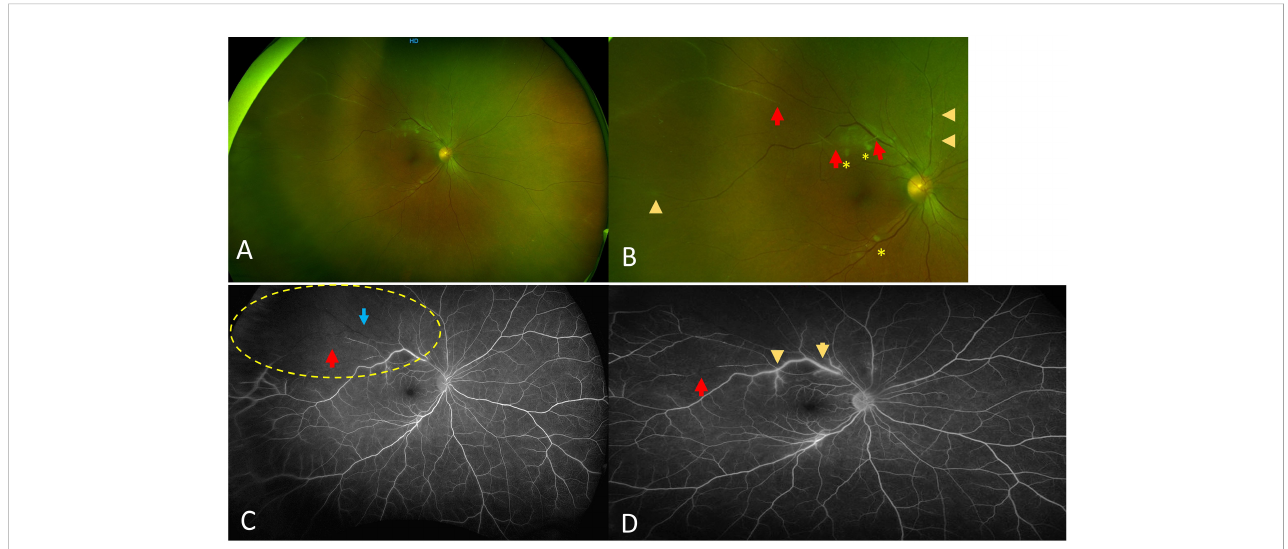
FIGURE 2 Case number 3. Optos fundus photos and wide fi eld fl uorescein angiography of a 61-year-old female with combined BRVO and BRAO due to mixed connective polyautoimmune SLE negative for antibodies for antiphospholipid syndrome but positive anti-RNP and meningo-encephalitis. (A) Wide view shows absence of vitritis with sheathing of both veins and arterioles. (B) close up that clearly shows sheathing from both veins (arrowheads) and arterioles (red arrows), asterisks show both veins and arterioles that are totally occluded with cotton-wool spots. (C) Intermediate phase FA shows sectoral lack of perfusion superotemporally (yellow dotted circle), with both arteriole (red arrow) and vein (blue arrow) showing lack of fl ow. (D) Late phase FA that shows staining of the veins compatible with periphlebitis (arrowhead) and partially occluded arteriolar fl ow proximally (yellow arrow) and distally (red arrow). The patient was treated with sectoral PRP following a period of eye quiescence.